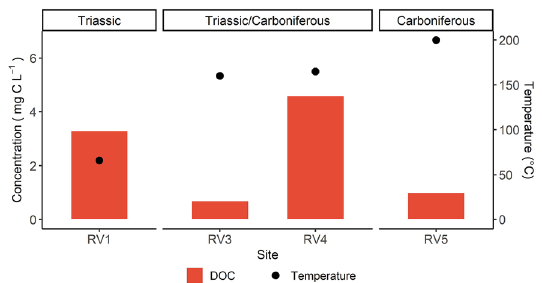
Fig. 11 Reported DOC concentrations and temperature for each reported site of the Upper Rhine Valley with samples from the production